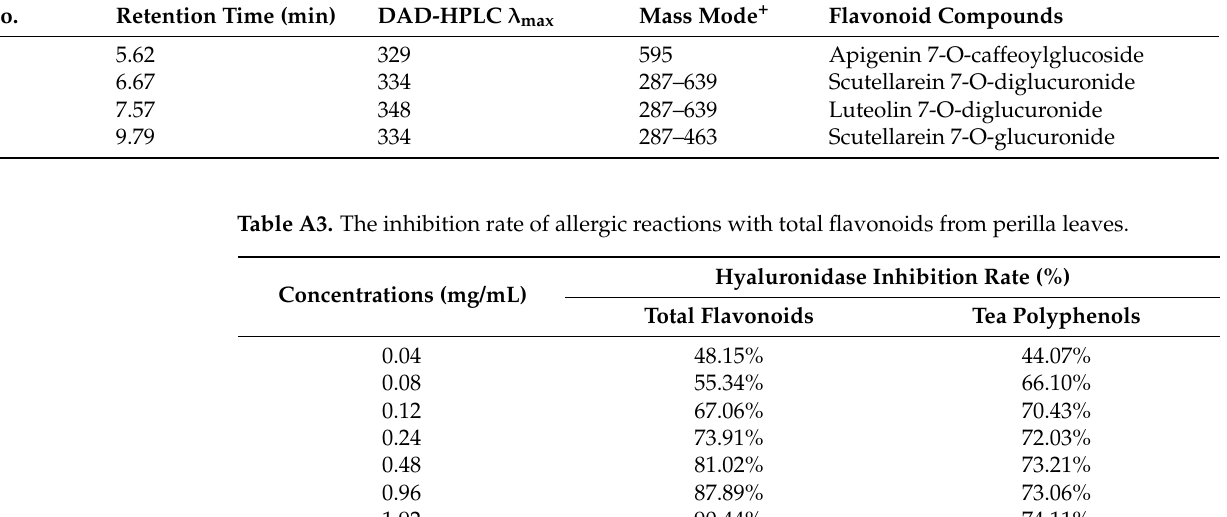
Table A2. Identification of flavonoid compounds from perilla leaves by HPLC-MS. Peak No.